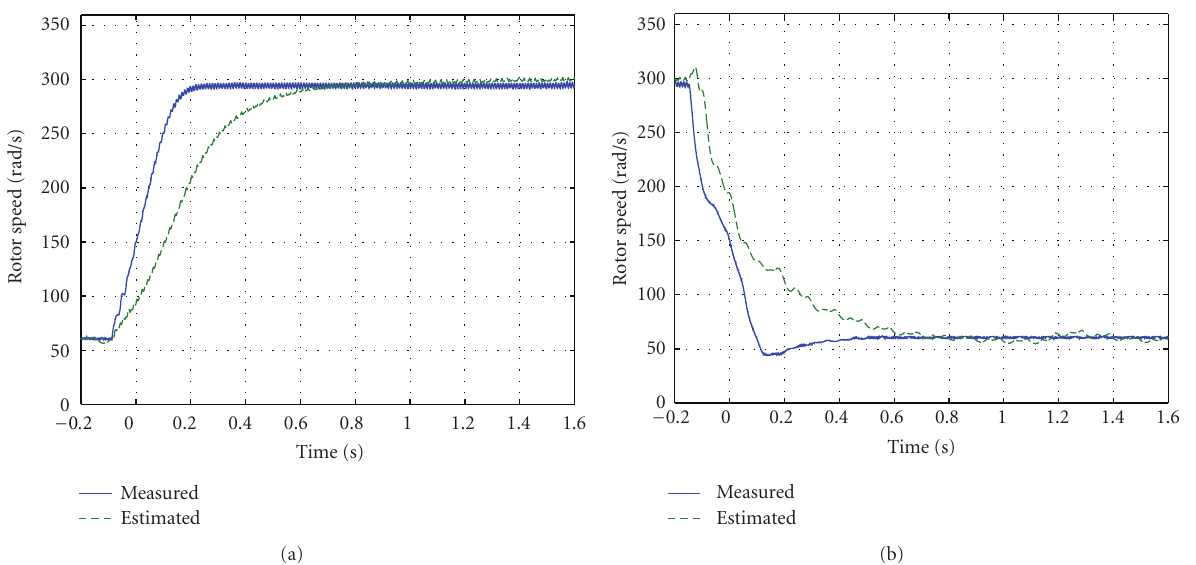
Figure 12: Estimated and measured rotor speed ω r of the SPIM during the step in the frequency stator (experimental results): (a) from 10Hz to 50Hz, (b) from 50 Hz to 10Hz.